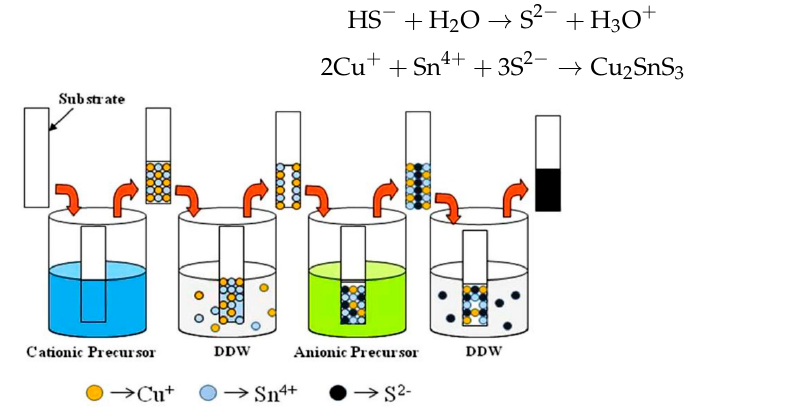
Figure 2. Schematic of the synthesis of CTS thin films by the SILAR method reproduced with per- mission from [33], Springer, 2017.